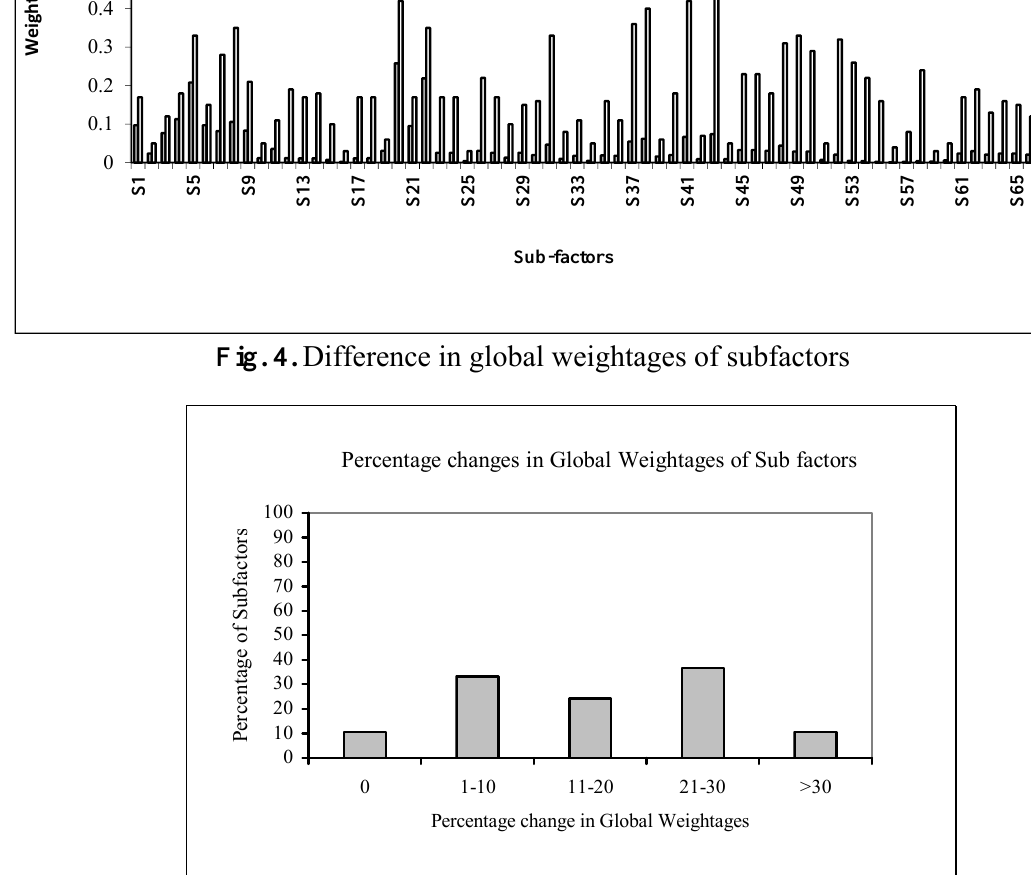
Fig. 5. Percentage difference in global weightages of